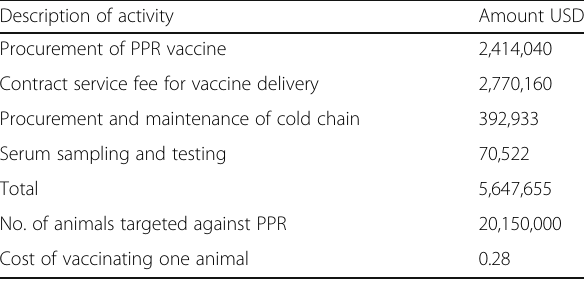
Table 7 Analyses of estimated cost of PPR vaccination campaigns and serological Survey in Somalia,